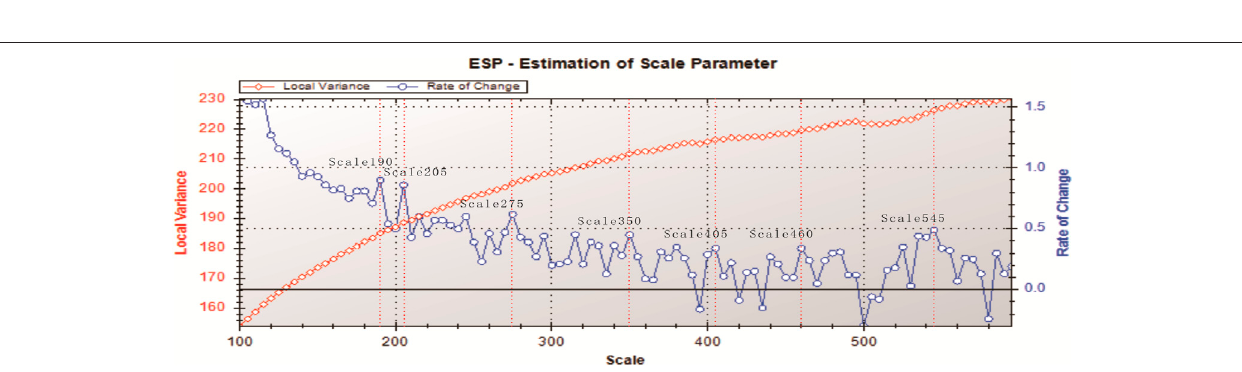
FIGURE 7 | Optimal segmentation scale of the QuickBird image obtained by